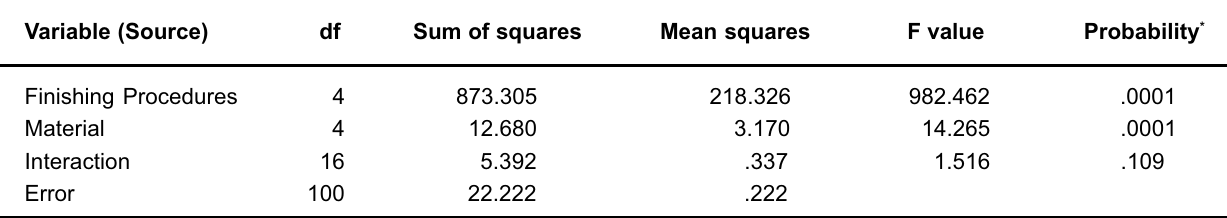
*Significantly different at p<0.05. TABLE 3- Mean values (standard deviation) of total color change ( ∆ E) of the composite resin restorative materials according to the evaluated groups